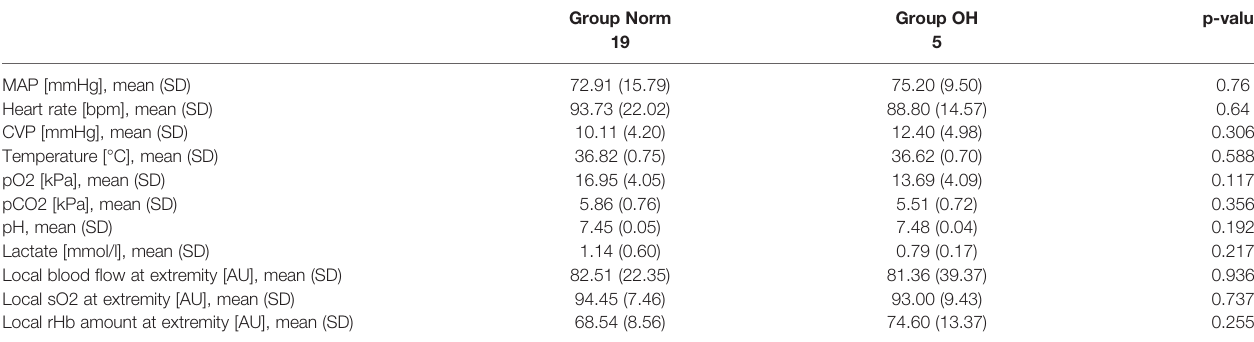
TABLE 1 | Baseline characteristics of study animals.